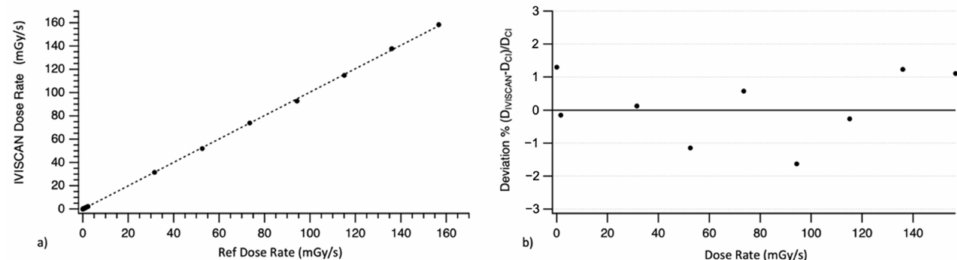
Figure 6. ( a ) IVISCAN ® response in air kerma rate related to reference ion chamber for air kerma rate between 0.005 and 160 mGy/s. ( b ) Deviation between air kerma rate measured by IVISCAN ® and reference ion chamber.